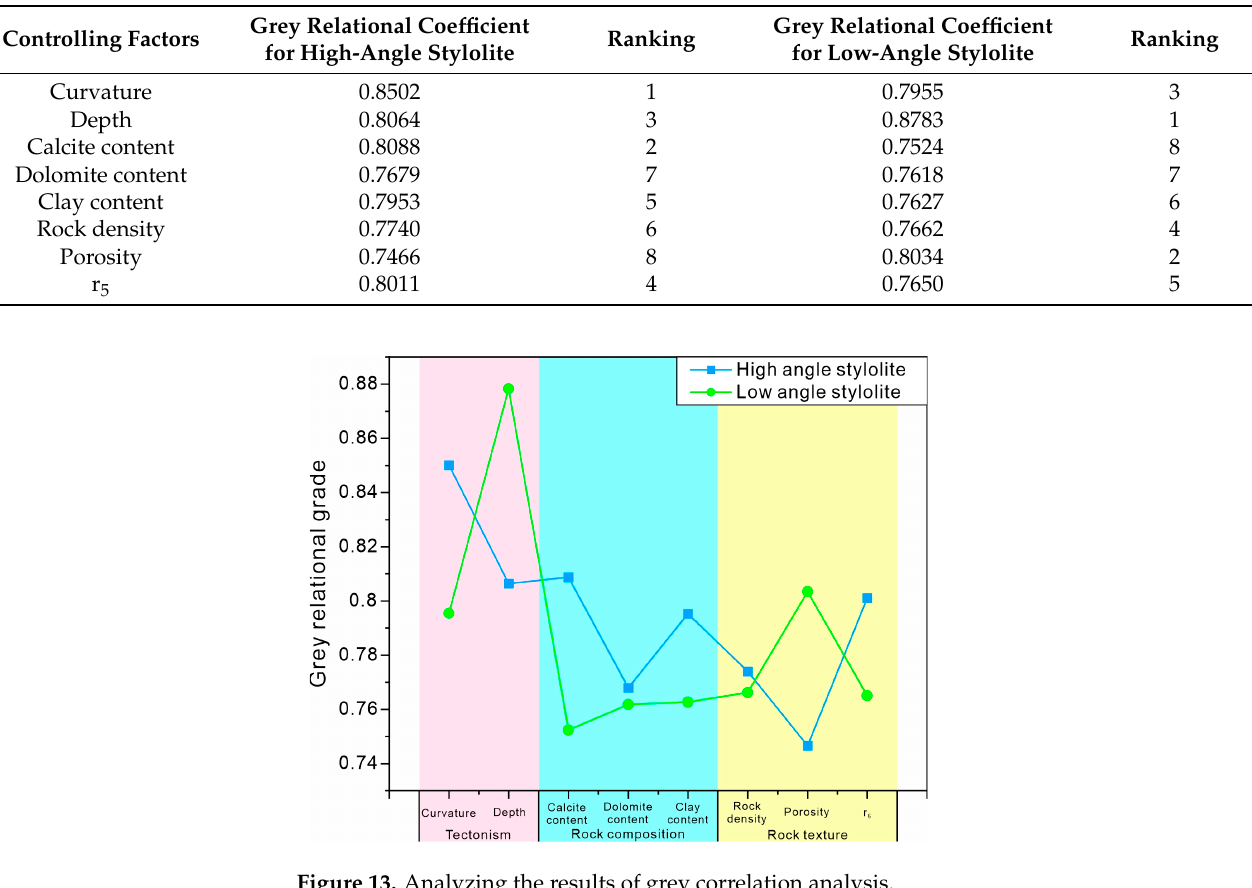
Table 3. Results of grey correlation analysis.